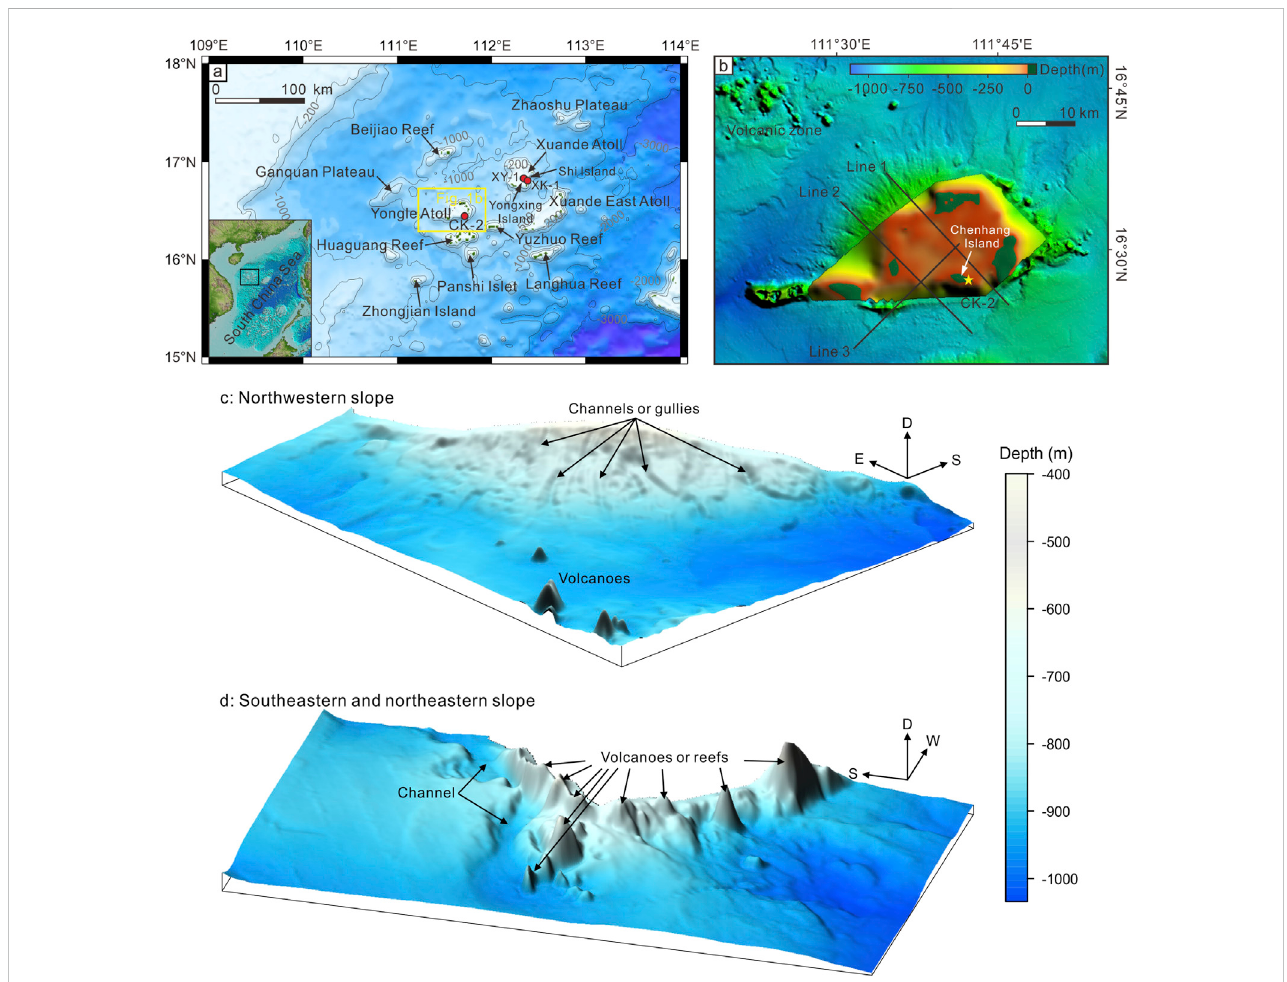
FIGURE 1 (A) Bathymetric map showing Xisha Archipelago with atolls and reefs. Red fi lled circles represent well locations. The yellow rectangle shows location of study area. Lower left inset indicates the South China Sea (SCS) and black rectangle shows location of Xisha Archipelago region. (B) Multi-beam bathymetric map of Yongle Atoll and surrounding regions. Shallow-water area, not covered by multi-beam data, was fi lled by global bathymetric data of GEBCO_ 2020 Grid. Black lines show locations of seismic pro fi les used in this study. (C) Geomorphologies of northwestern slope and (D) southeastern and northeastern slopes of Yongle Atoll. D: Depth; E: East; S: South; W: